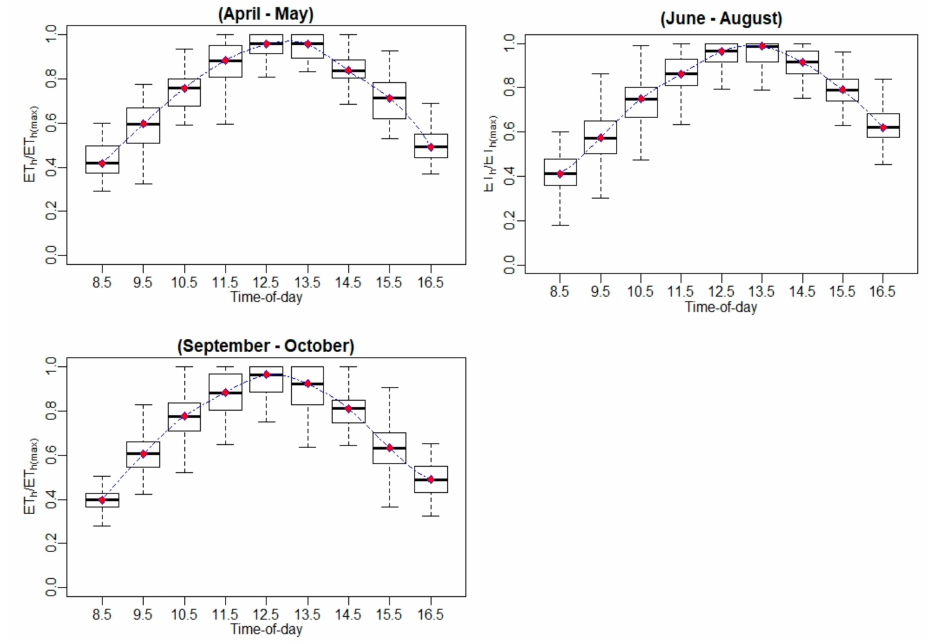
Figure A20. Hourly ET -to-maximum hourly ET ratio ( ET h /ET h(max) ) variation using EC measure-